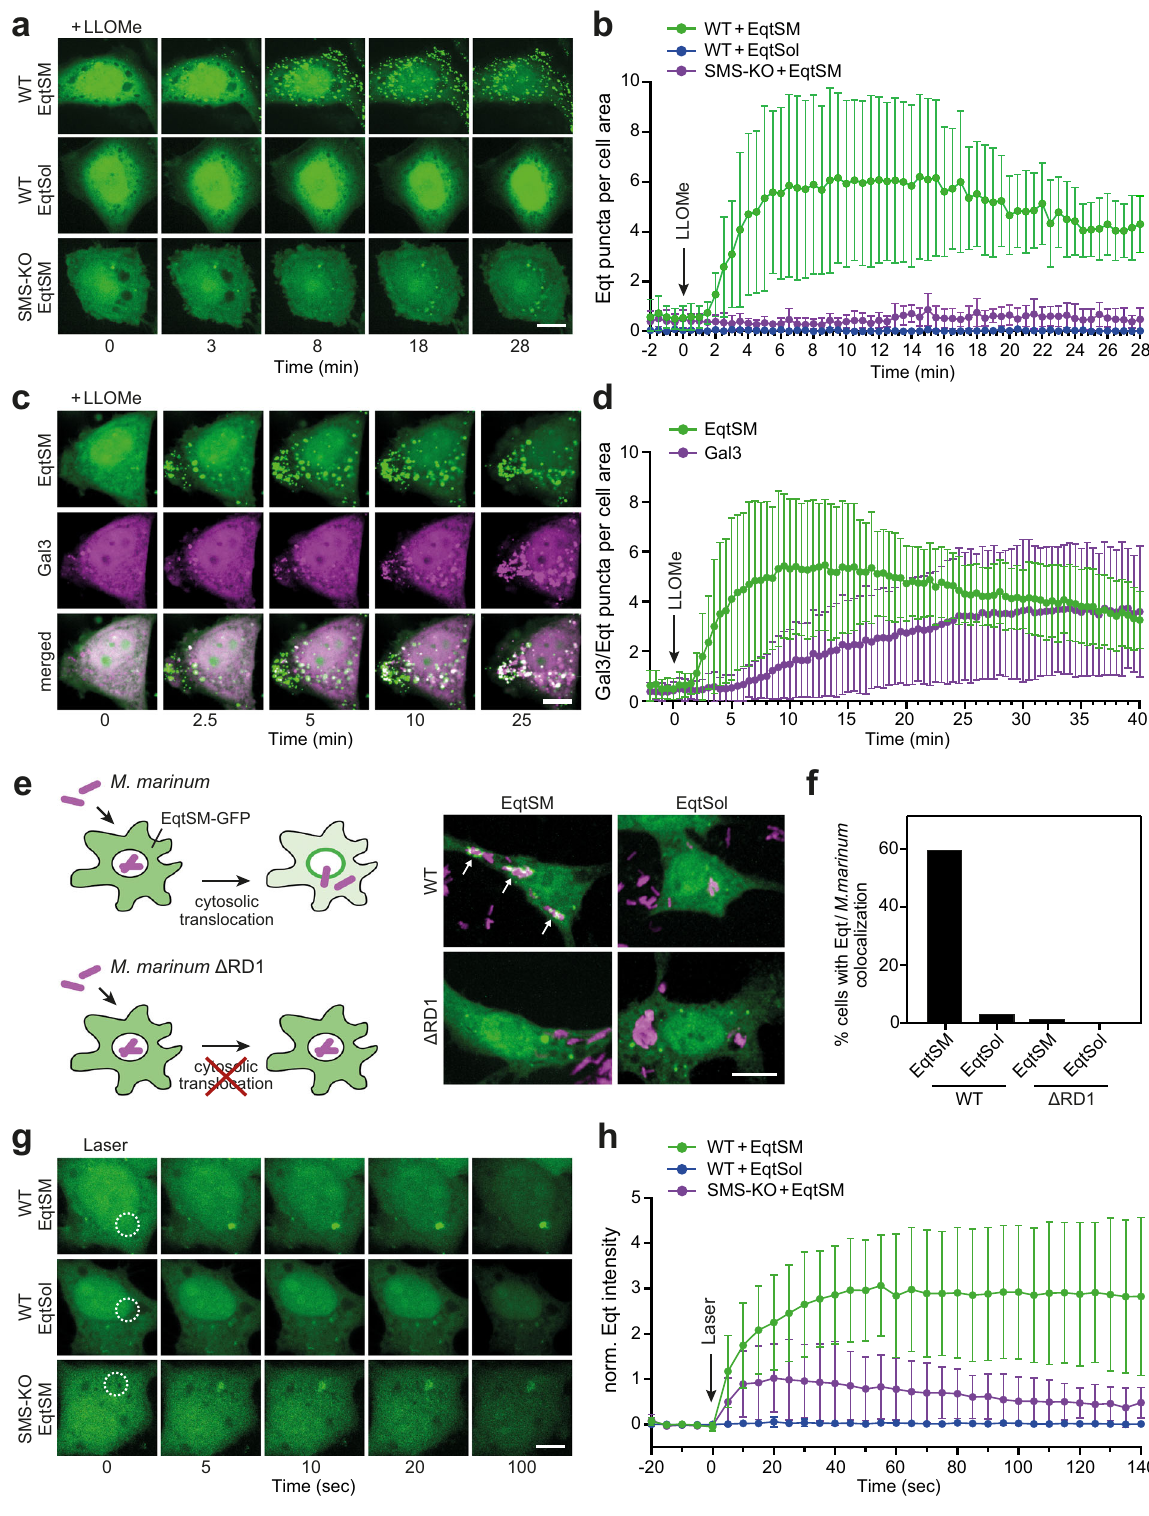
Δ RD1, which fails to translocate to the cytosol and